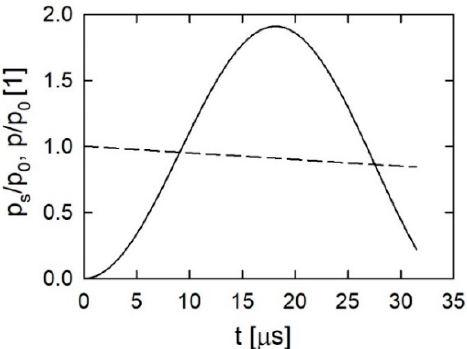
Figure 9. The model pressure course inside the primer (dashed line) and the response calculated using Equation (24) (solid line).